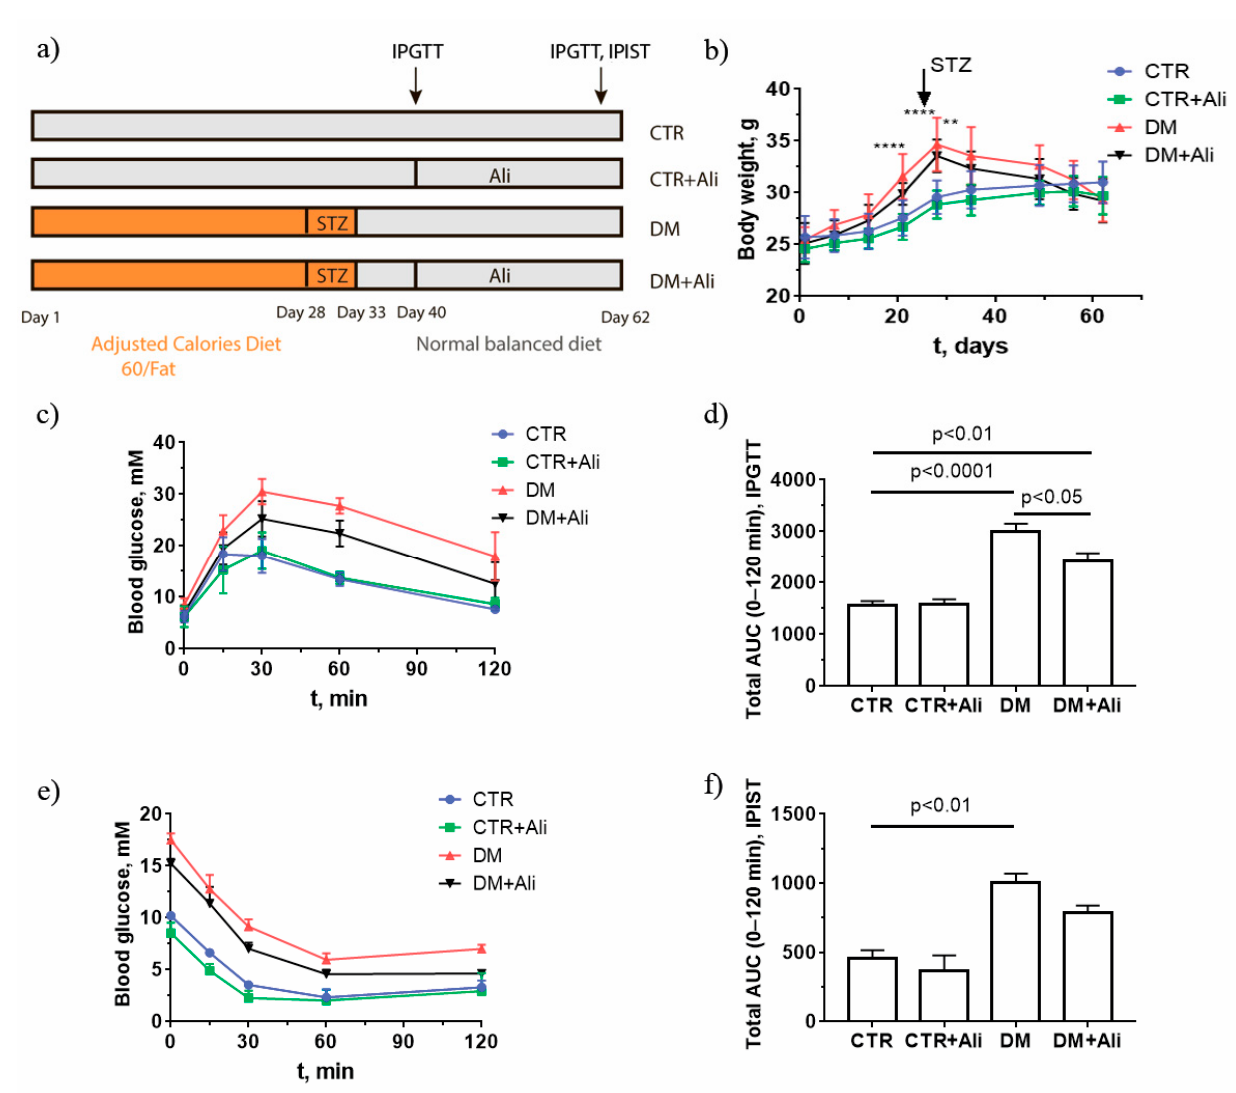
Figure 1. Induction scheme of diabetes mellitus ( a ), body weight gain ( b ), intraperitoneal glucose tolerance test, IPGTT ( c ), and intraperitoneal insulin sensitivity test, IPIST ( e ) in control (CTR), alisporivir-treated control (CTR+Ali), diabetic (DM), and alisporivir-treated diabetic (DM+Ali) mice. The total areas under the curve (AUC) of the IPGTT ( d ) and IPIST ( f ). The tests were conducted on the 60th day from the beginning of the experiment. ** In subfigure b, the difference between the CTR and DM+Ali groups is significant at p < 0.01. **** differences between the CTR and DM groups are significant at p < 0.0001. All data are presented as mean ± SEM ( n =